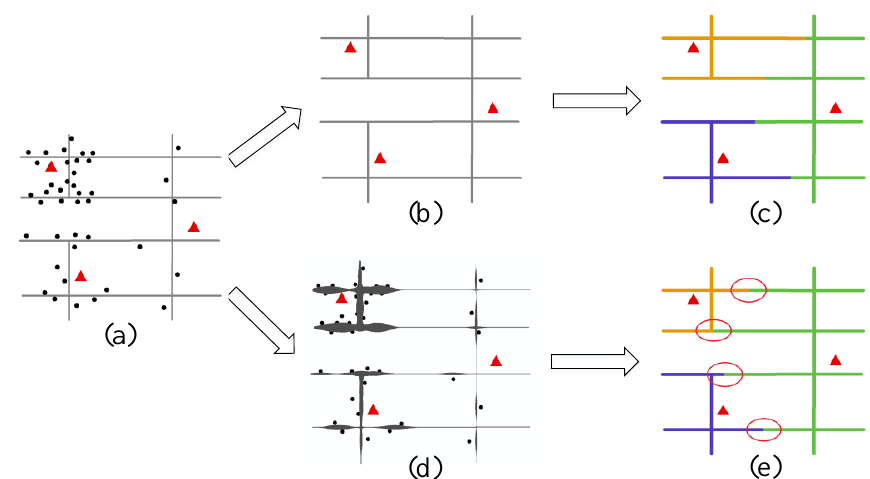
Figure 3. The generating process of the Voronoi diagram with (or without) considering fire risk variation across space: ( a ) the original data of fire stations (red symbols), fire accidents (black symbols), and street network (black lines); ( b , c ) the Voronoi diagram constructed by considering only the geometric length of street segment; ( d ) the fire risk calculated by network kernel density estimation of fire accidents; and ( e ) the constrained Voronoi diagram constructed by considering both the geometric length and fire risk.